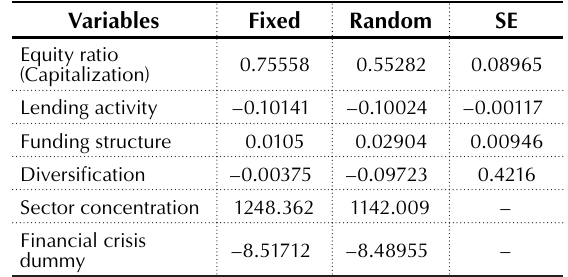
Table 1. Hausman tests – random versus fixed